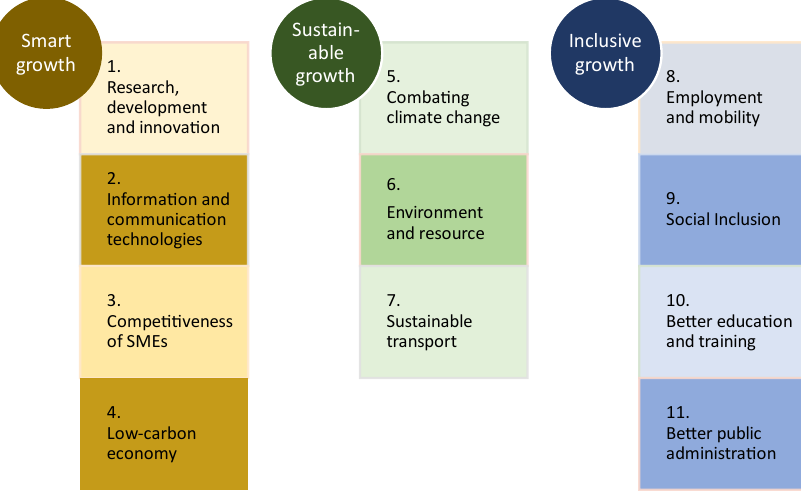
Figure 12. Thematic objectives of ETC programmes 2014 – 2020. Source: own study based on [52].